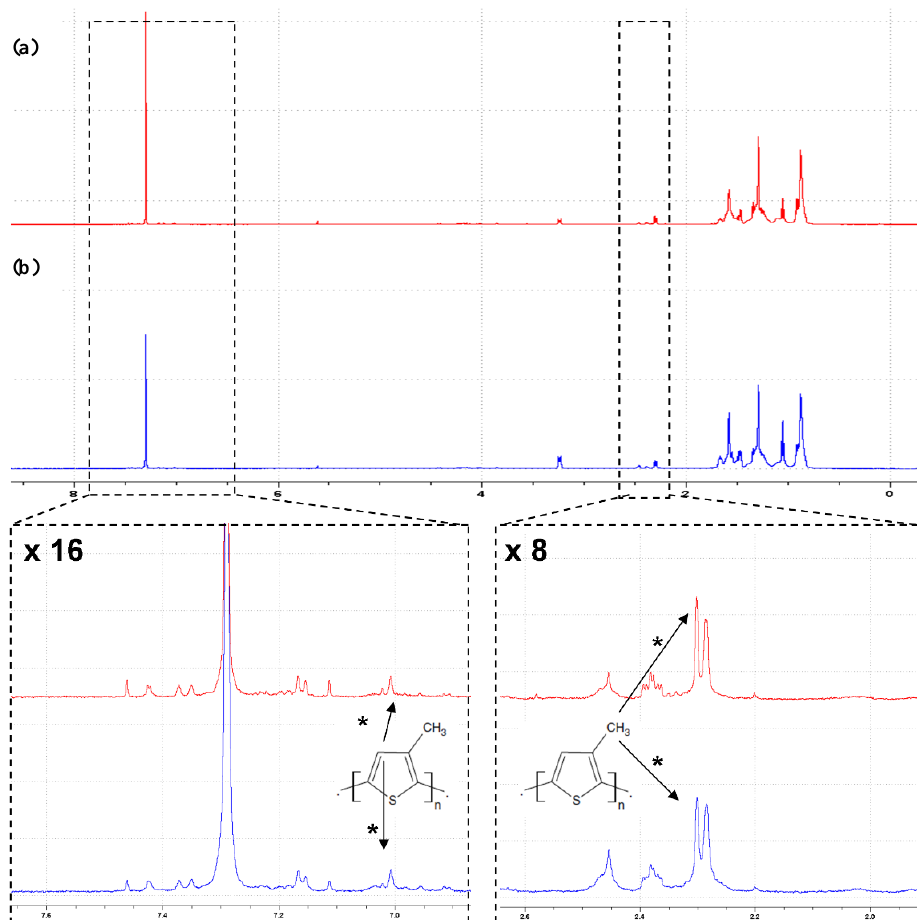
Figure 6. 1 H NMR spectra for poly (3-methylthiophene) fibers, with ( a ) and without ( b ) imprinted drug molecule (for AMOX).